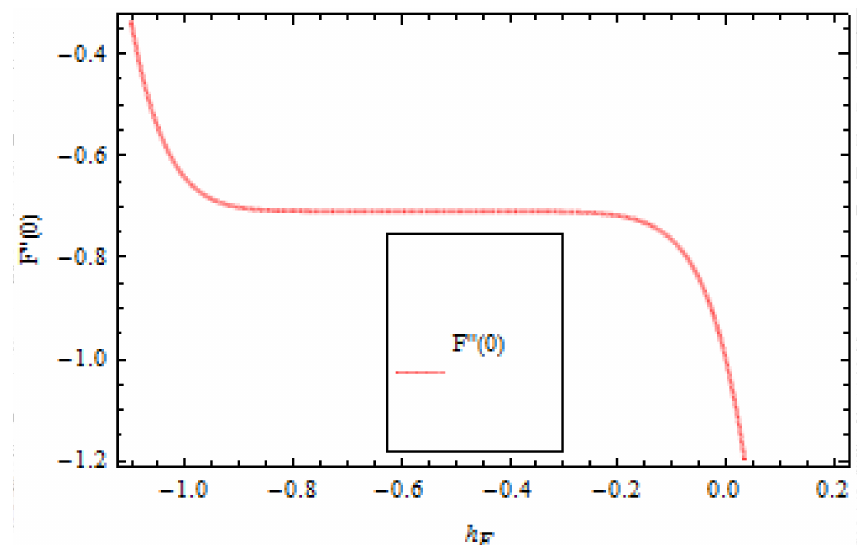
Figure 2. The (cid:125) -curve graph of velocity profile, when Pr = 0.5, K = 0.5, Rd = 0.5, λ = 0.5, κ = 0.5, γ = 0.5, Sin τ = 1.0, A = 0.5.